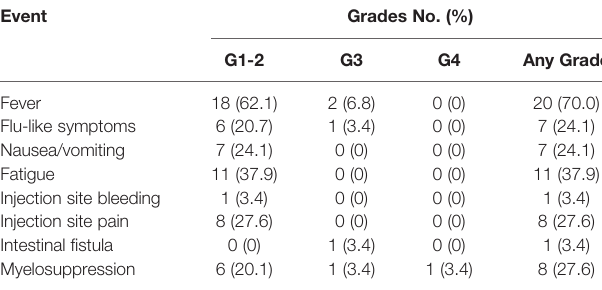
TABLE 3 | Treatment-related Adverse